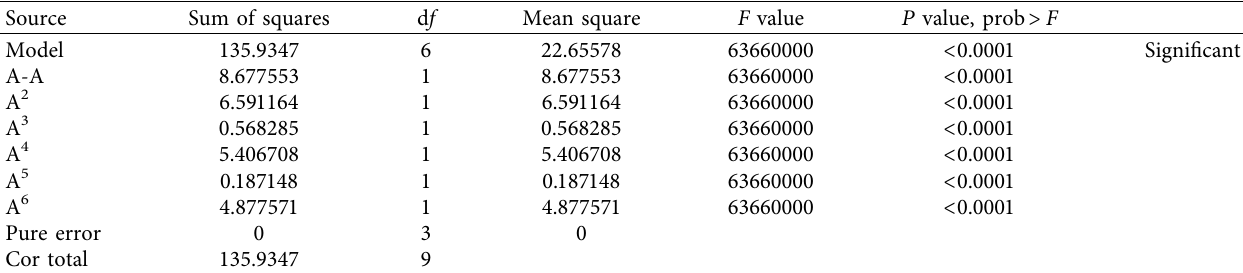
Table 9: ANOVA analysis of rice bran PLA composite.